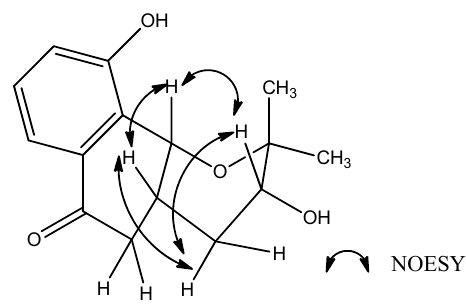
Figure 3. Selected NOESY correlations of compound 1